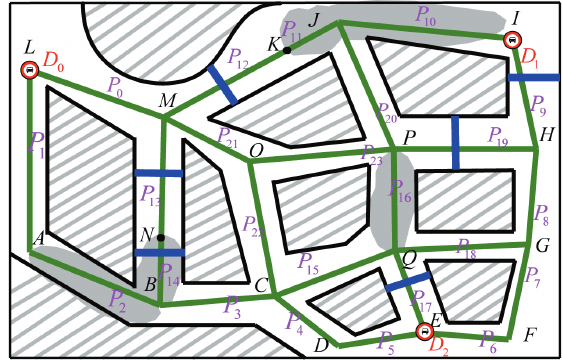
Fig. 7. Topological map of environment.